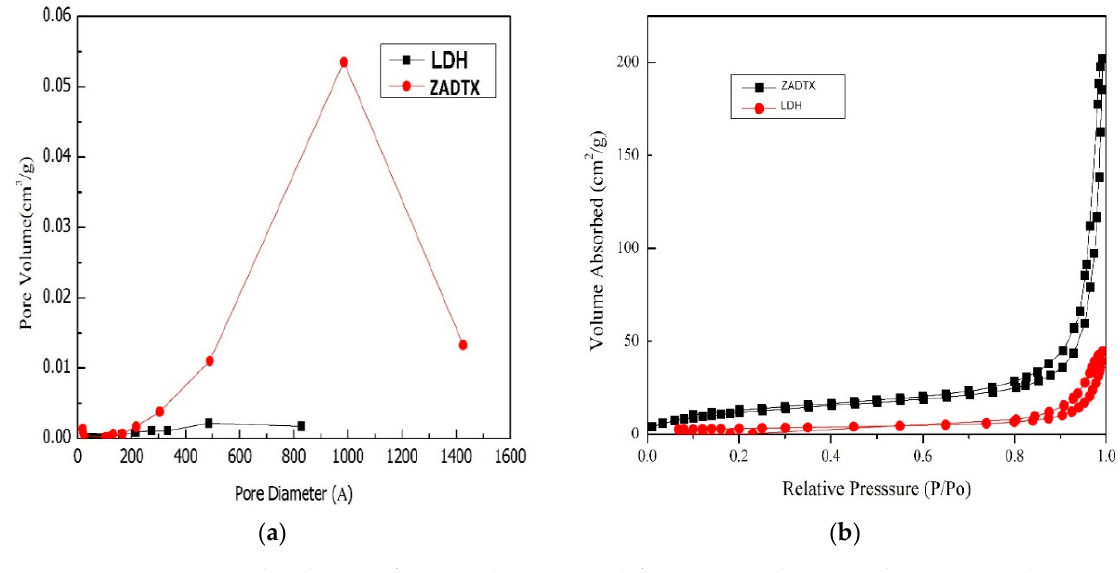
Figure 7. ( a ) Pore size distribution of LDH and ZADTX and ( b ) Nitrogen adsorption-desorption isotherms. Table 2. Surface properties of LDH and ZAMDTX.